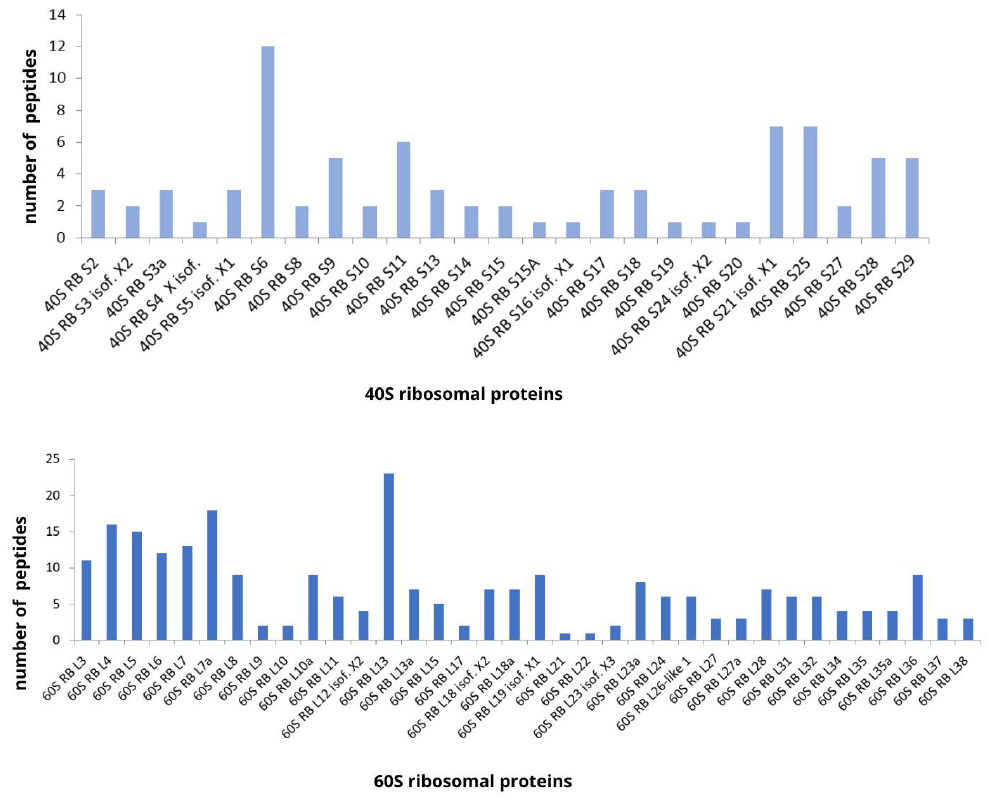
Figure 5. Number of peptides identified for each ribosomal protein that constitute the 40S small subunit and the 60S large subunit of eukaryotic